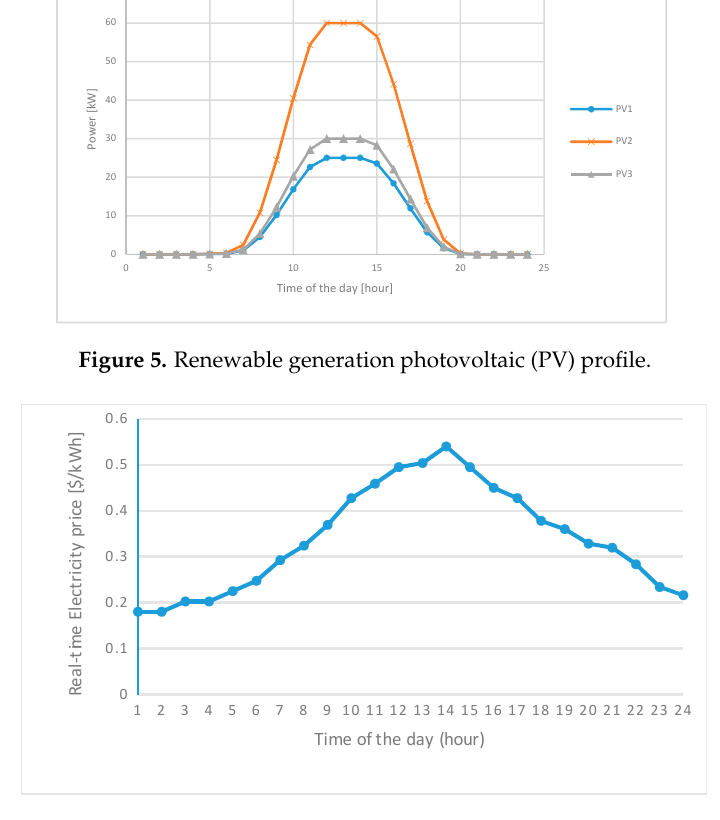
Figure 6. Real-time price profile.